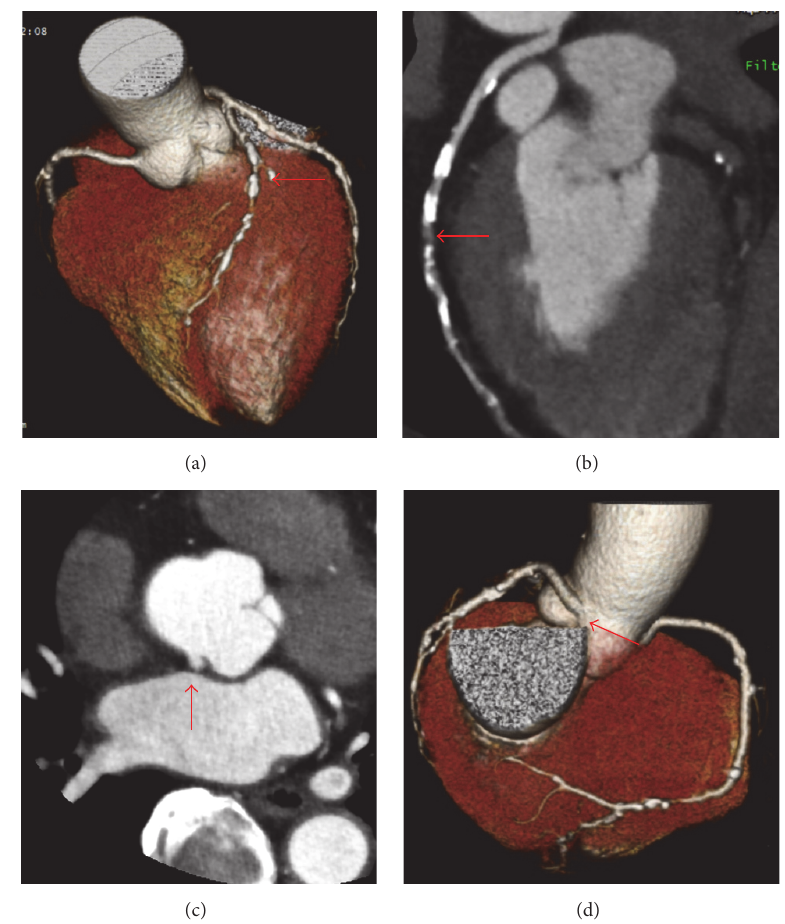
Figure 2: (a) CT (3D view) showing stenosis of the mid-LAD artery (indicated by the red arrow). (b) Multiplanar reconstruction view of the LAD artery (CT). The red arrow shows stenosis of the mid-LAD artery. (c) Red arrow showing arising ostium of the LCA (sectional view, CT). (d) Red arrow showing arising ostium of the LCA (3D view,